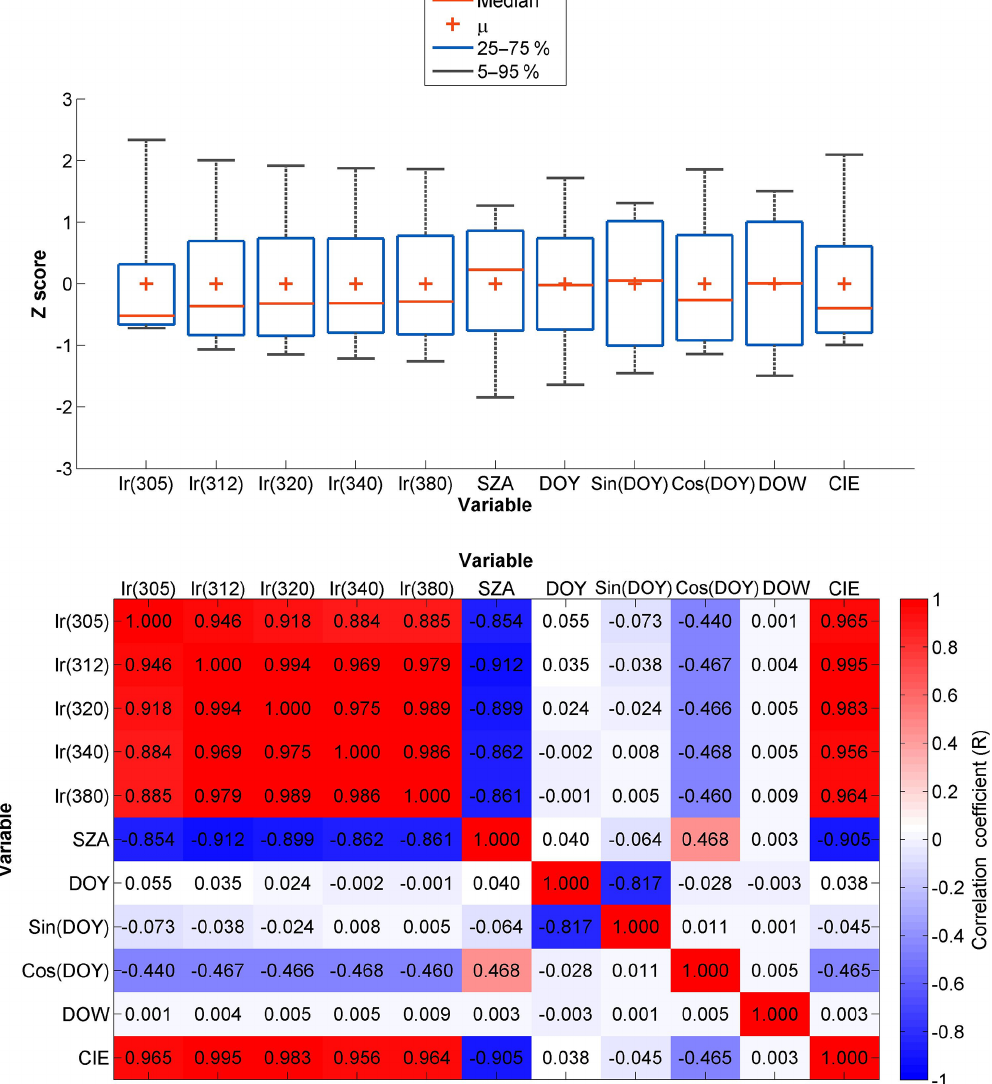
anti-correlate with SZA ( − 0 . 891 ≤ r ≤ − 0 . 909), and